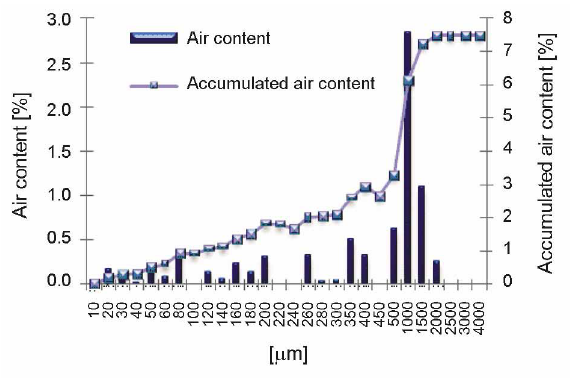
Fig. 1. Air void content according to its size in non air-entrained SCC investigated according to EN 480-11 (2006) (CEM I 32.5